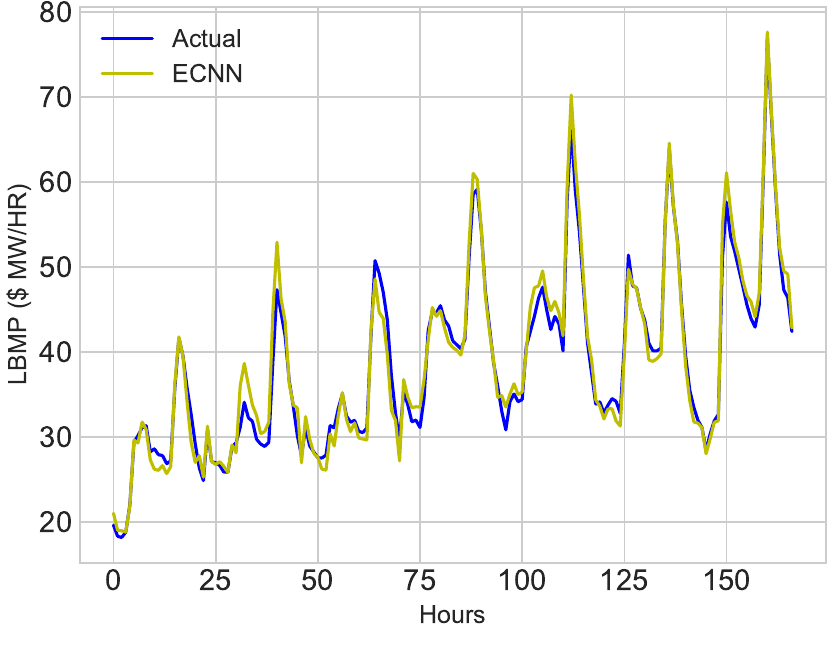
Figure 15. First Week of January, 2017.